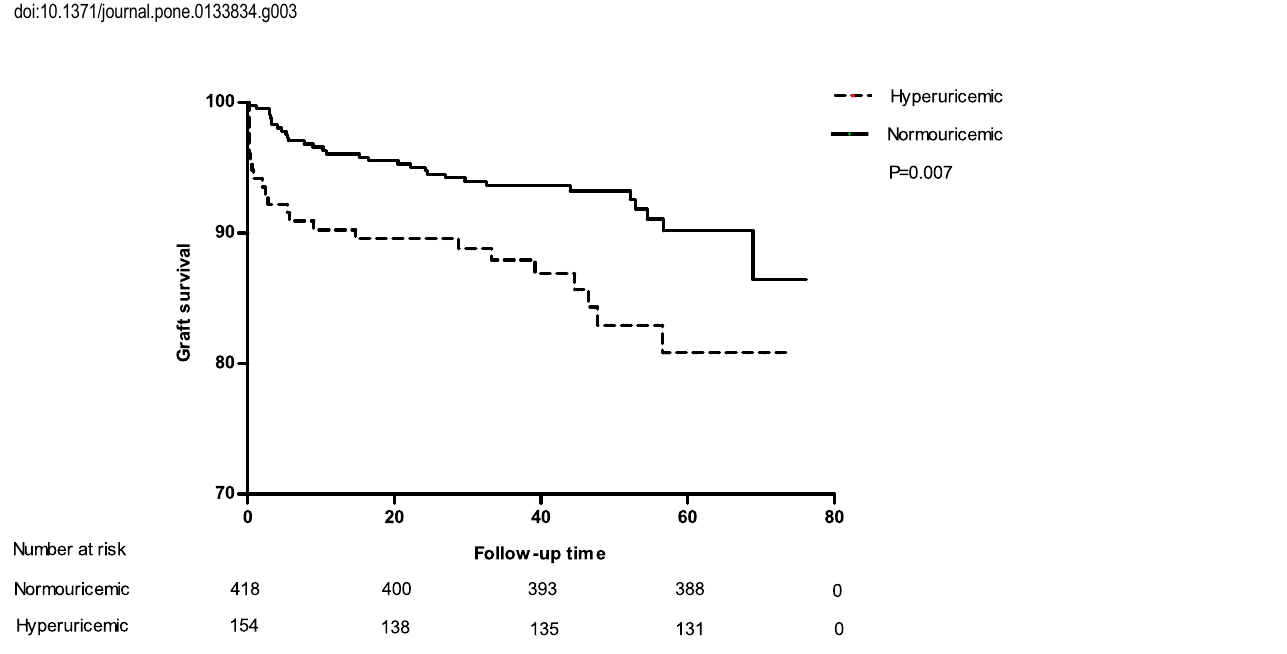
Fig 4. Kaplan-Meier survival curve estimates for graft loss. Hyperuricemic group survival curve was significantly (P = 0.007) lower than that of normouricemic group.Graft loss was defined as graft failure (return to dialysis) or death with functioning graft.